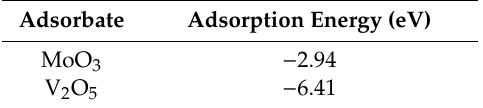
Table 4. Adsorption energies corresponding to the two di ff erent oxides on